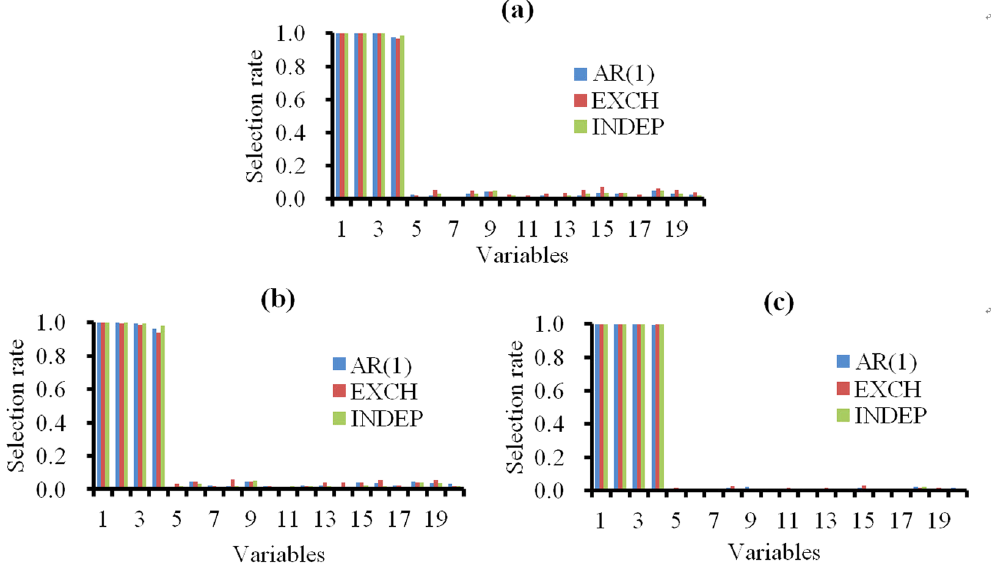
Figure 2. Model selection performance of the pQIF under three different working correlation structures. The true correlation structures are assumed as ( a ) AR(1) structure, ( b ) EXCH (exchangeable) structure, ( c ) INDEP (independent) structure. AR(1), EXCH (exchangeable), and INDEP (independent) in each sub-part are the working correlation structures. The bootstrapped sample size is 300, p = 20, and ρ = 0.5. The horizontal axis represents the variables, where 1 represents covariate age and 2–4 represent the three gene variables (MAP4, TNN, and NRF1).